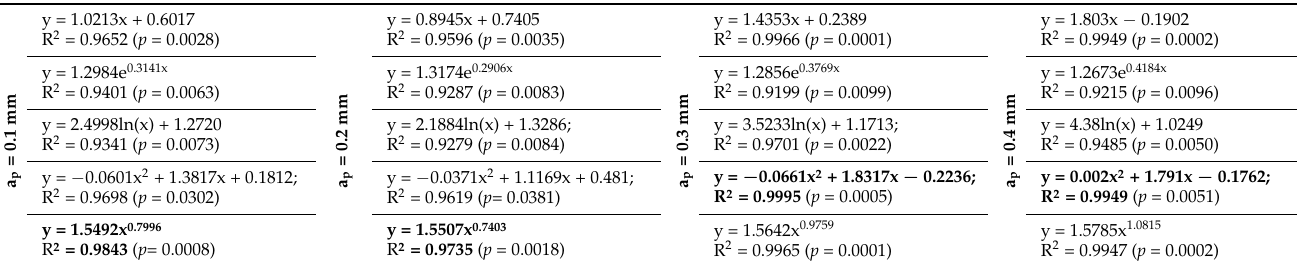
Table 2. Artificial neural network learning parameters. Table 3. Results of mathematical modelling of the Sa parameter as a function of the feed rate for different values of the depth of cut (regression functions y = Sa(f z ); f z = x with the coefficient of determination R 2 ).